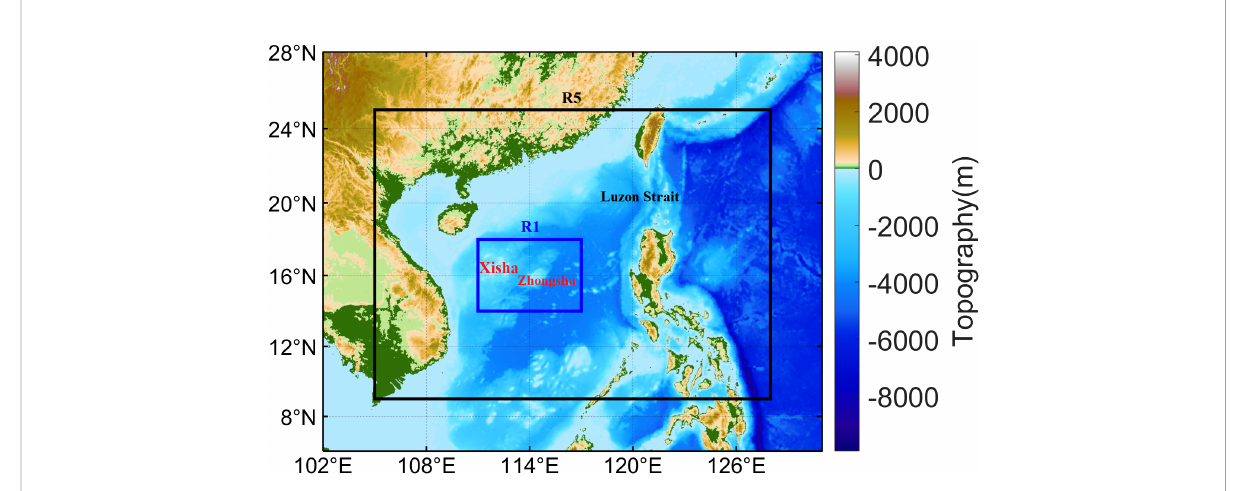
FIGURE 1 Topography of simulated area (unit: m). The black and blue lines denote the parent and nested domains, R5 and R1,